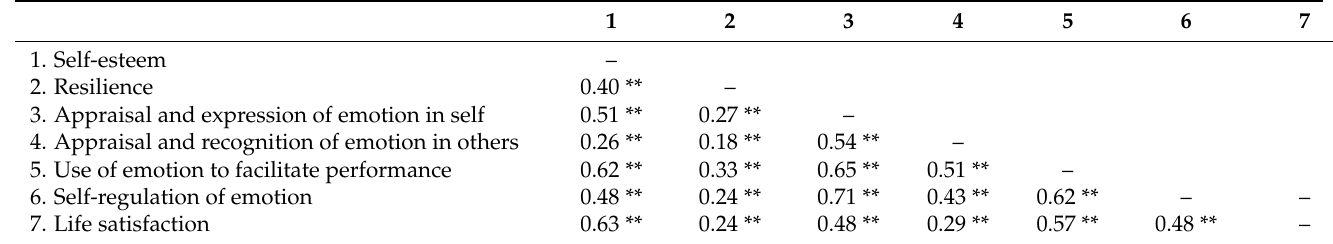
Table 2. Correlation matrix of the study variables (n = 2574).